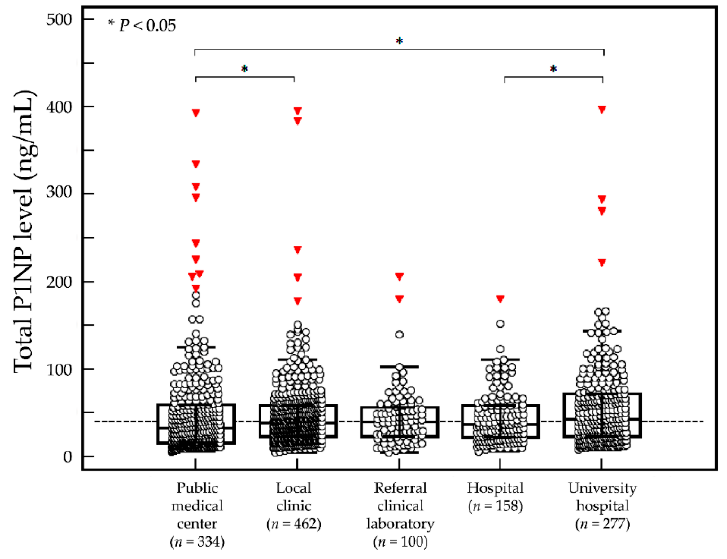
Figure 2. Baseline serum P1NP level during initial measurement by type of medical institution for 1331 Korean adults. The middle line represents the median, and the central box represents values from the lower to upper quartiles (25 to 75th percentiles). ( ○ ) represents individual serum P1NP result, and ( ▼ ) represents outlier.